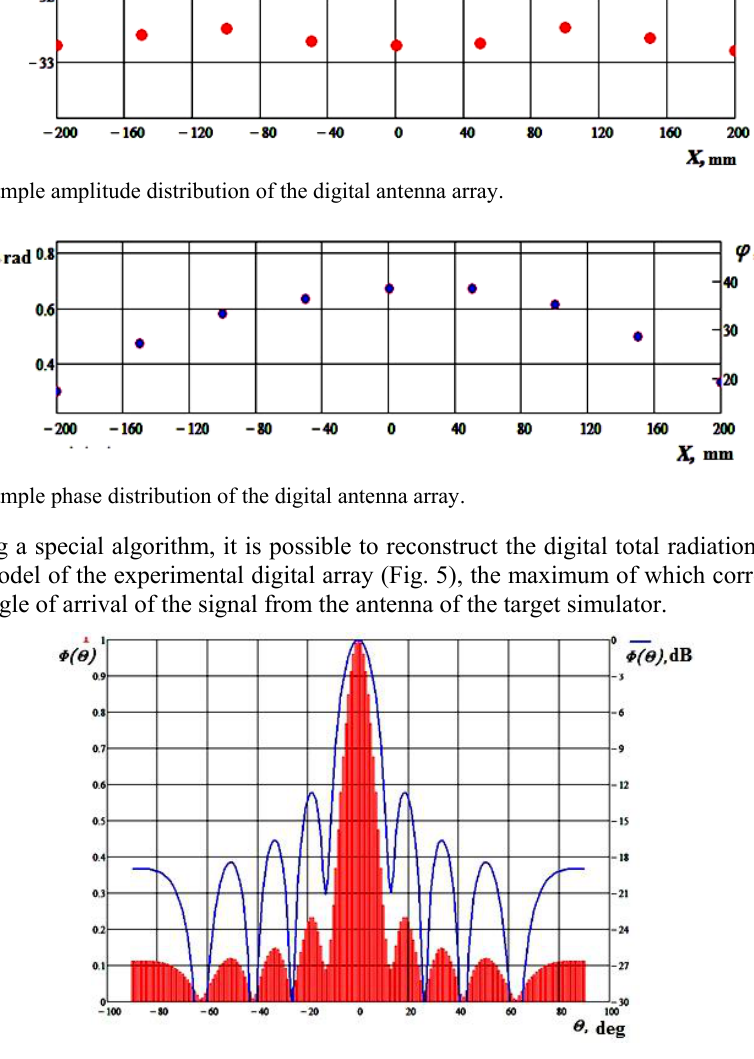
Fig. 5. The directional pattern of experimental DAA, the angle of arrival is 0